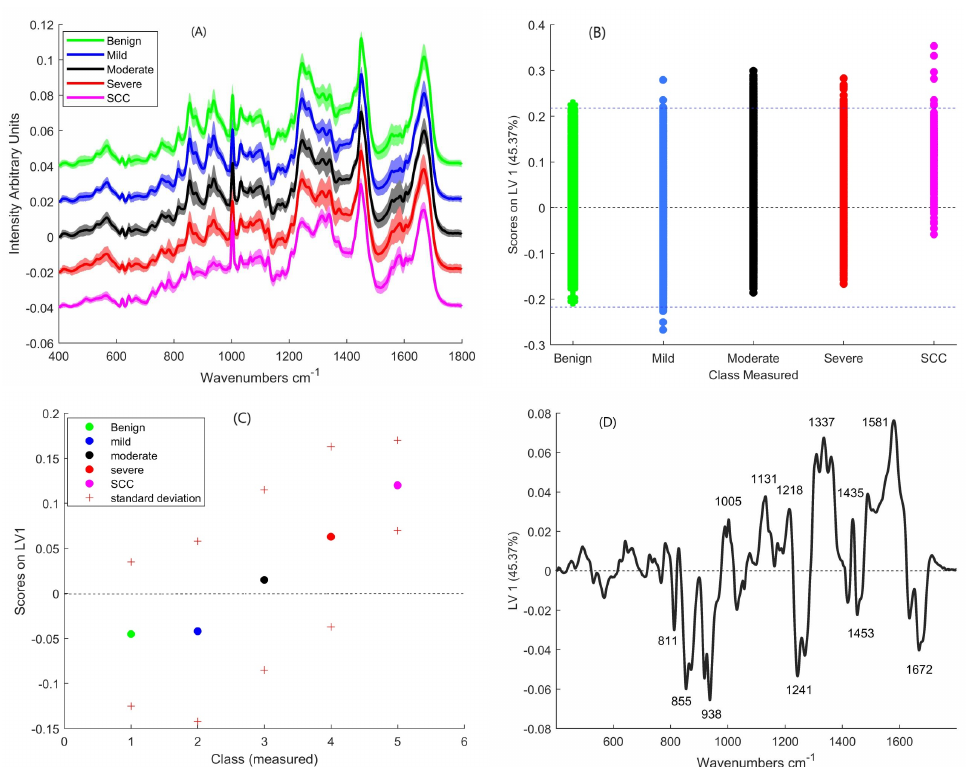
Figure 2. ( A ) Mean Raman spectra of benign, mild, moderate severely dysplastic and SCC connective tissue. The spectra have been offset for clarity and shading denotes standard deviation ( B ) A plot of the PLSDA scores of LV-1 ( C ) Mean and standard deviation of PLSDA scores of LV-1 ( D ) Loading of LV-1 of the PLSDA model which included all the